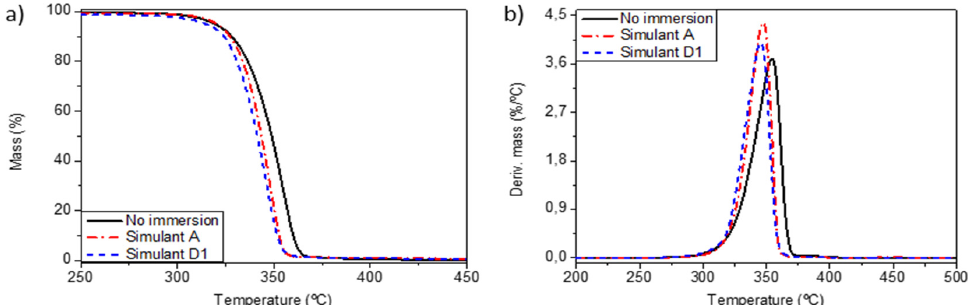
Figure 7. Weight loss ( a ) and derivative weight loss ( b ) of PLAV before and after immersion.